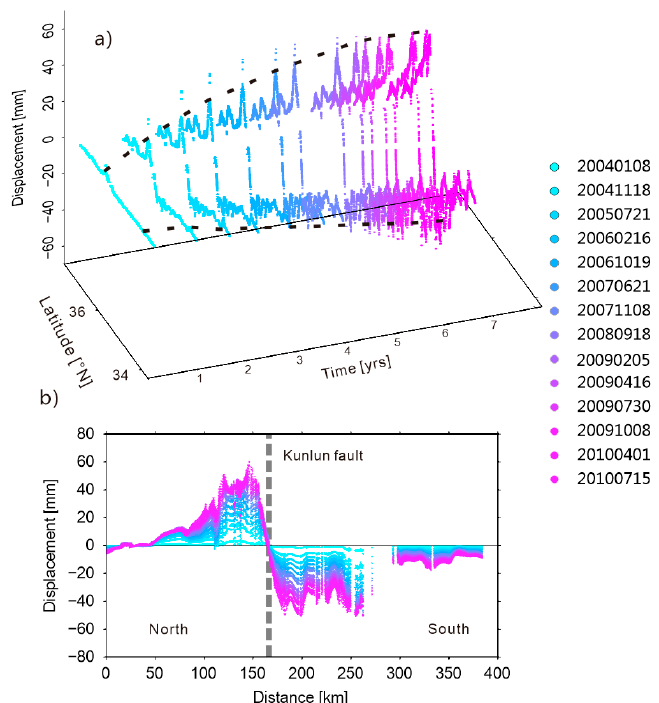
Figure 15. The 3D ( a ) and plane view ( b ) of fault perpendicular profiles of line of sight (LOS) cumulative displacement across the Kunlun fault on track 133 as a function of time, color-coded by their acquisition date relative to 30 October 2003. The grey dashed line shows the approximate location of the Kunlun fault. The profile is taken from the central T133 timeseries and its location is shown in Figure 14.